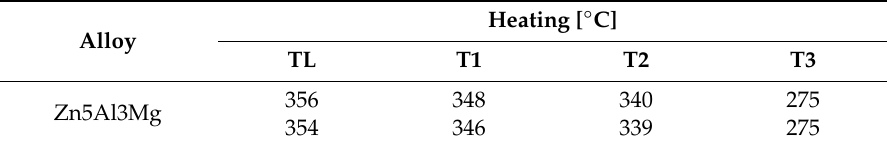
Table 3. Temperatures of phase transformations by DSC analysis.